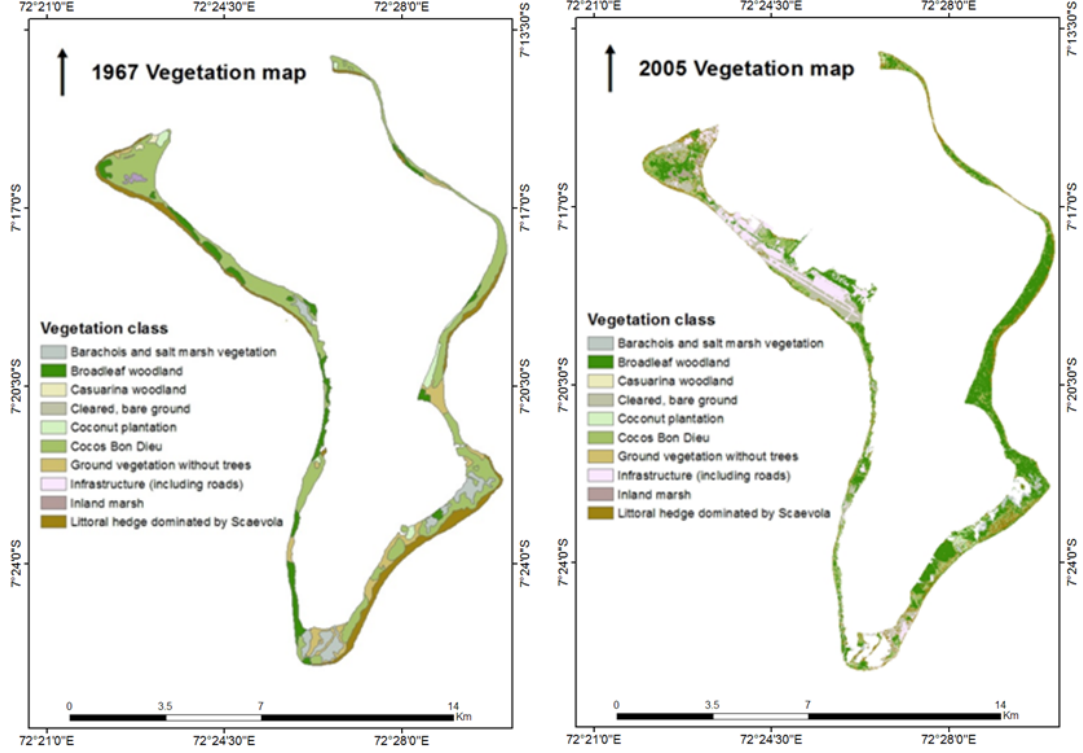
Figure 5. Atoll vegetation in 1967 (Stoddart, 1971) and 2005 derived from the IKONOS satellite images.